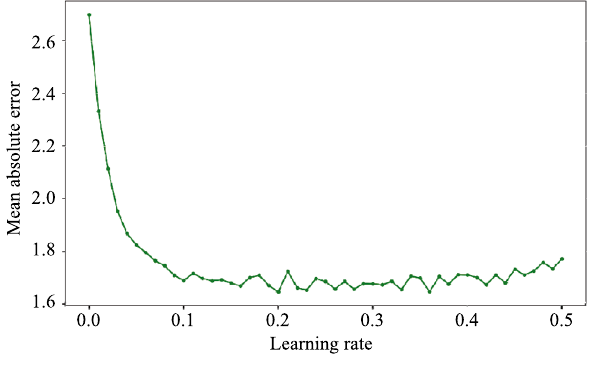
Fig. 8 MAE function with the number of trees